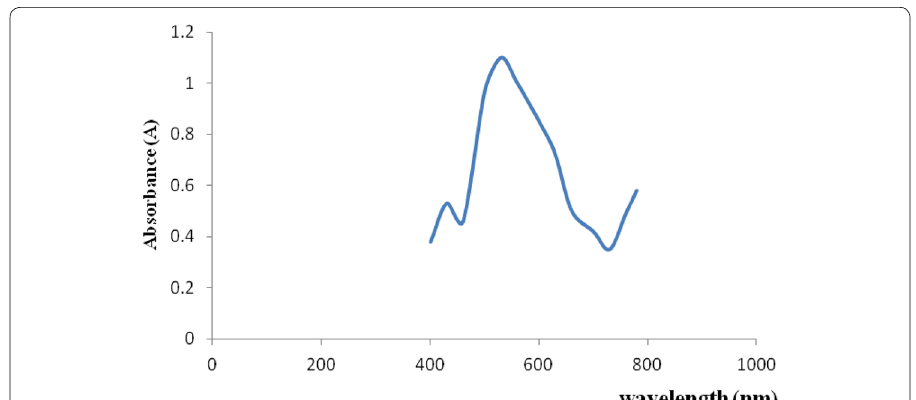
Fig. 6 Absorption spectrum of B. ferruginea dye solution